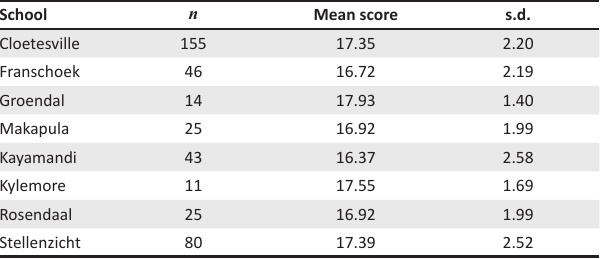
TABLE 2: Participant feedback on perceived impact on career